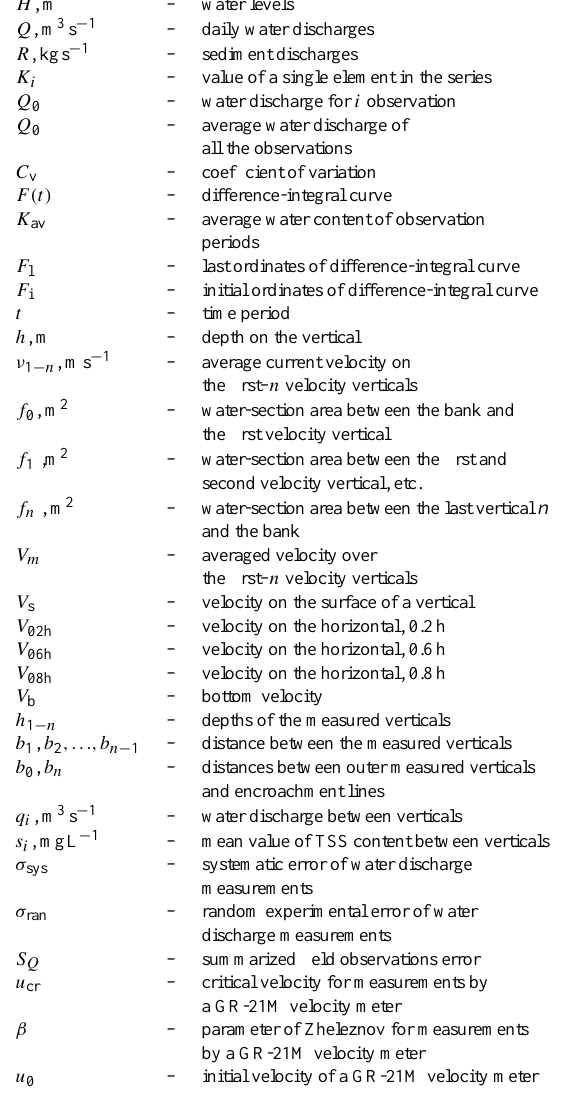
Table 7. List of